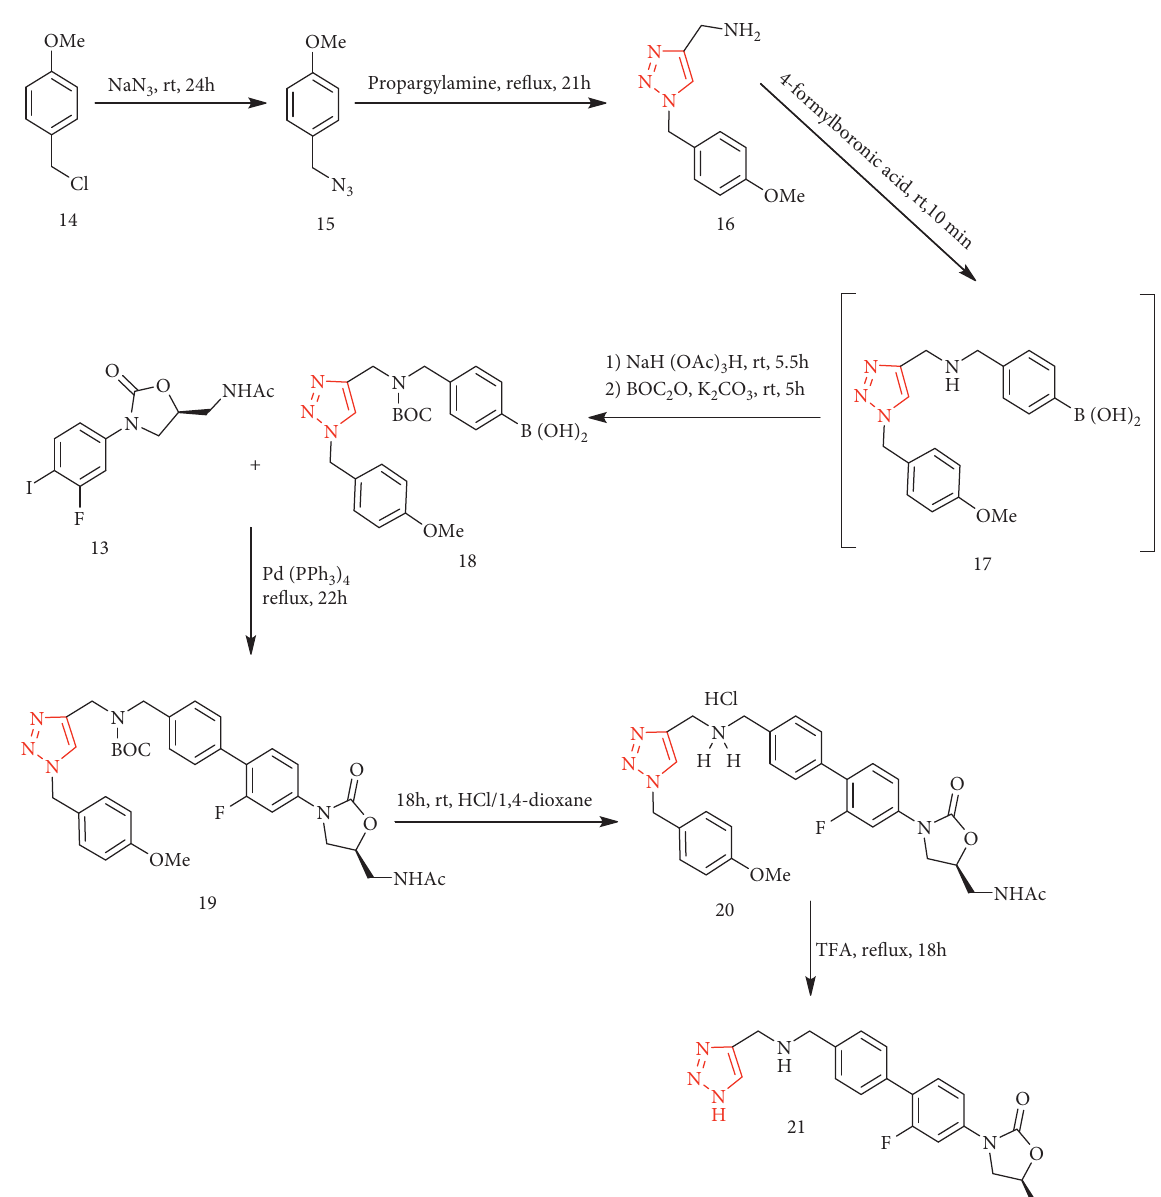
Scheme 12: Pathway of Radezolid